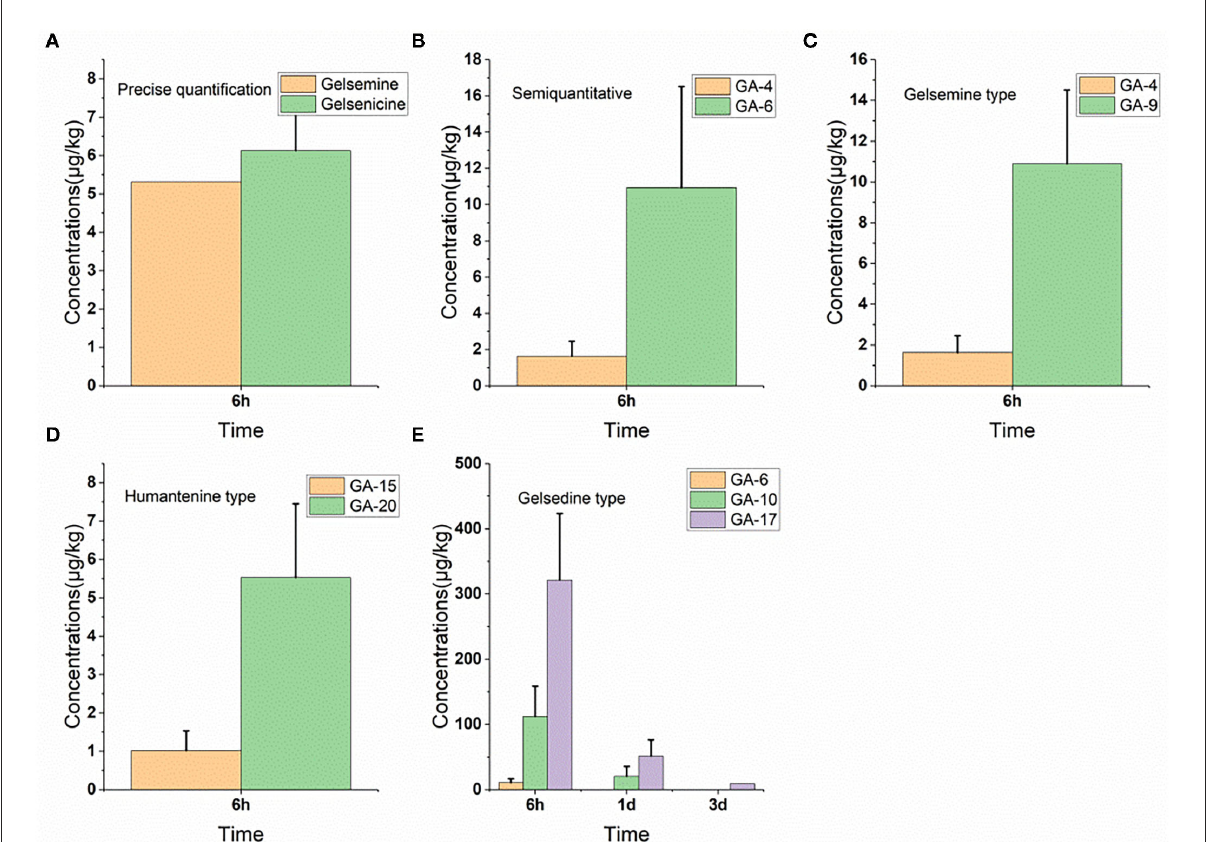
FIGURE5 (A–E) Depletion of Gelsemium alkaloids in pig plasma after 45 d of consecutive administered G. elegans powder at a dose of 2% per kilogram